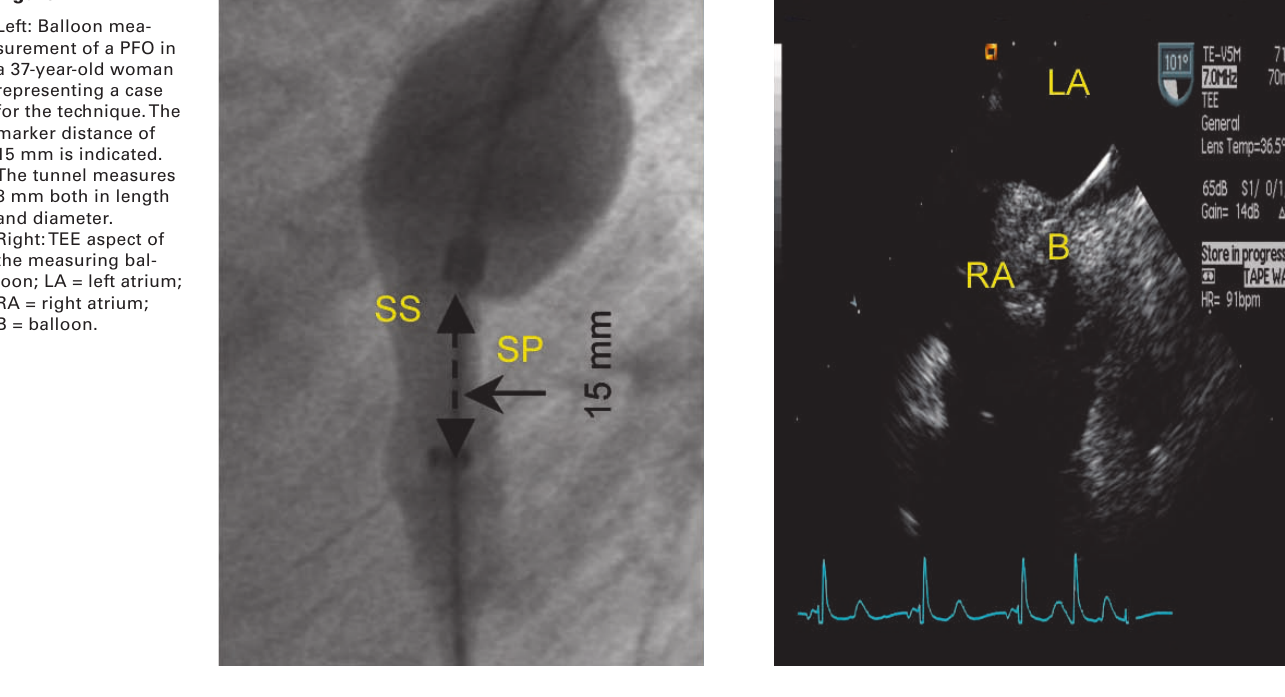
Left: Balloon mea - surement of a PFO in a 37-year-old woman representing a case for the technique. The marker distance of 15 mm is indicated. The tunnel measures 8 mm both in length and diameter. Right: TEE aspect of the measuring bal- loon; LA = left atrium; RA = right atrium; B =